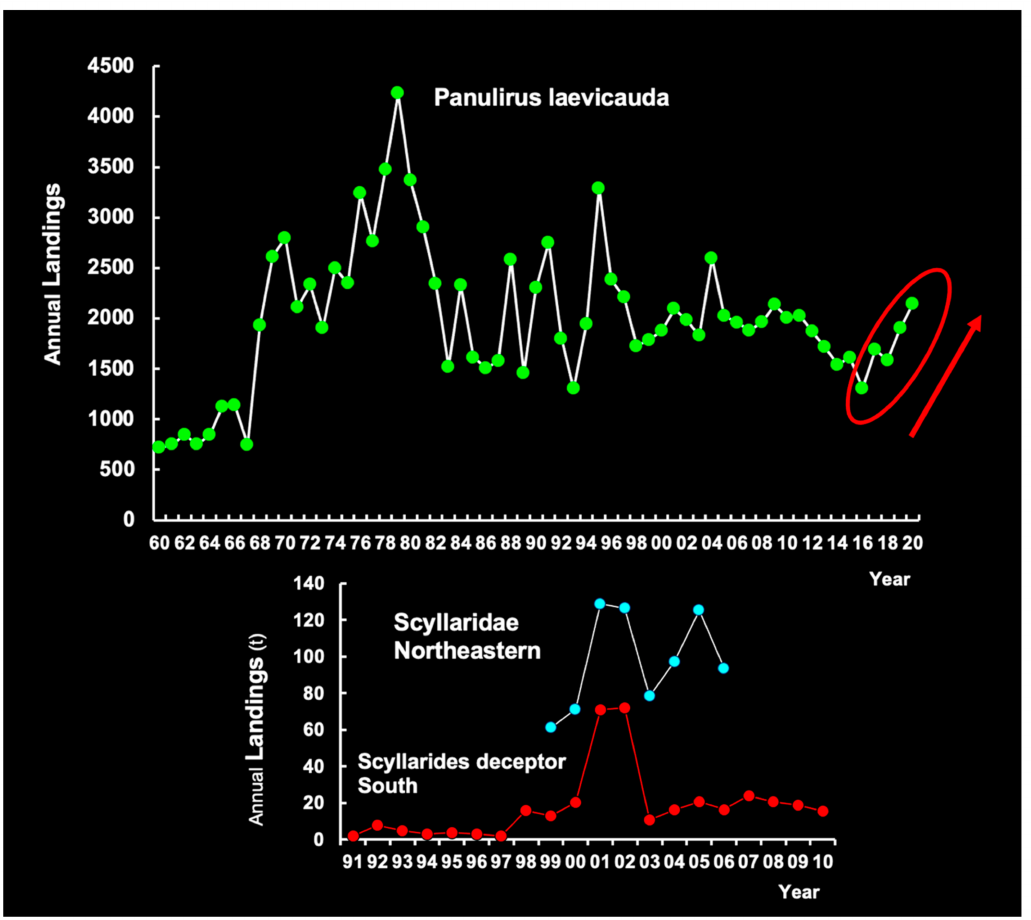
Figure 10. Fluctuations in annual green lobster landings ( Panulirus laevicauda Latreille, 1817). Oval circle and red line show an increase in landings since 2016. Lower graph shows landings of several species of Scyllaridae ( Scyllarides brasiliensis Rathbun, 1906; Scyllarides delfosi Holthuis, 1960 and Parribacus antarcticus (Lund, 1793) in Northeast, and landings of Scyllarides deceptor Holthuis, 1963 in the South. Adapted from Cruz et al.